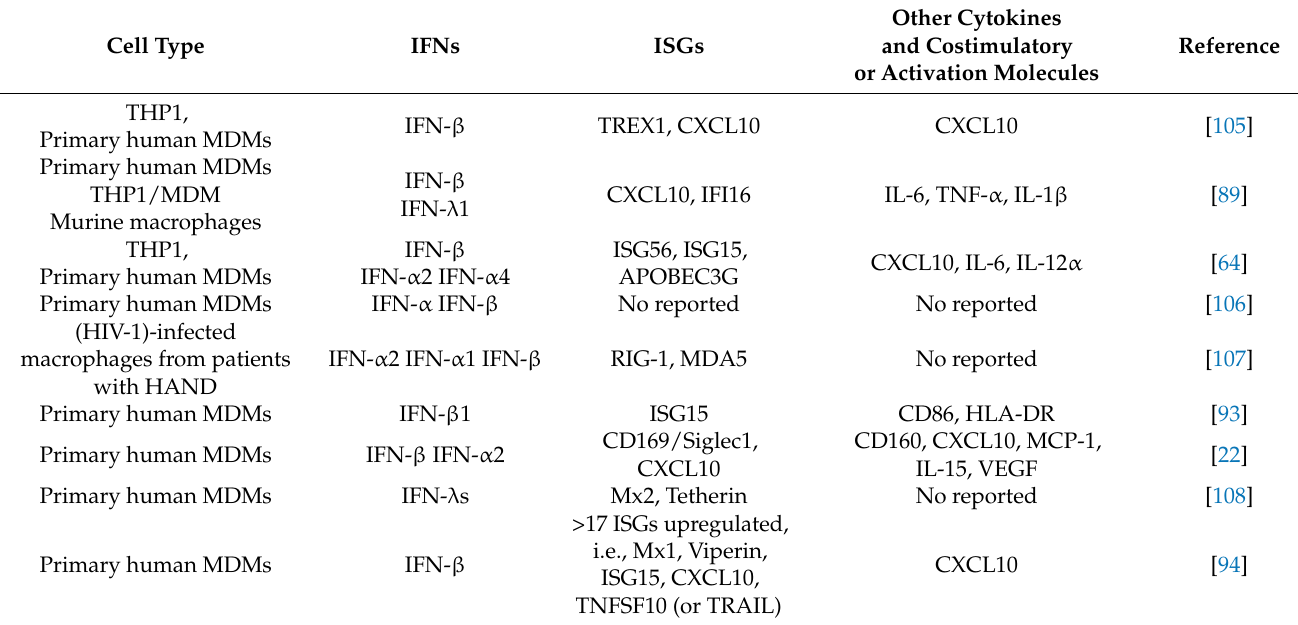
Table 1. Induction of IFN/ISG and pro-inflammatory molecules, reported downstream of HIV-1 sensing in